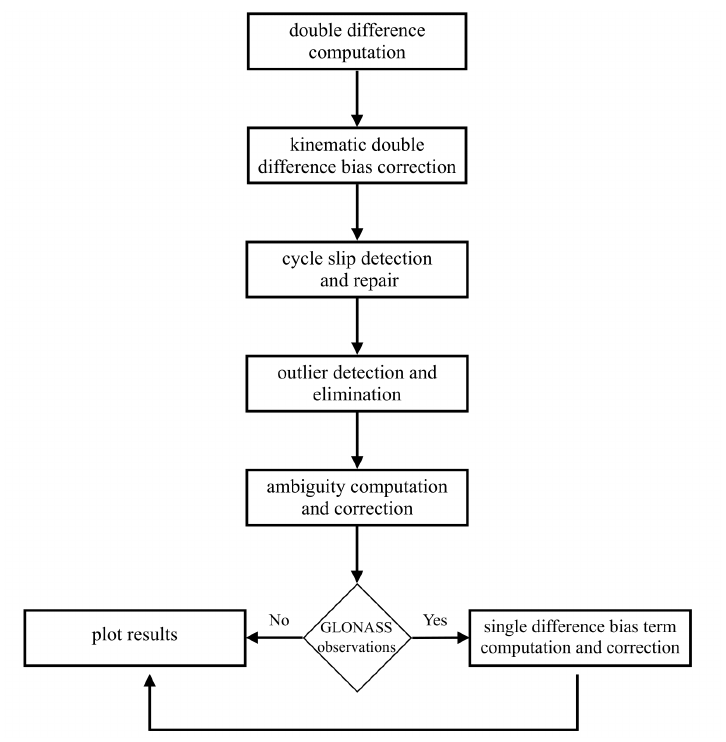
Figure 7. Double difference processing